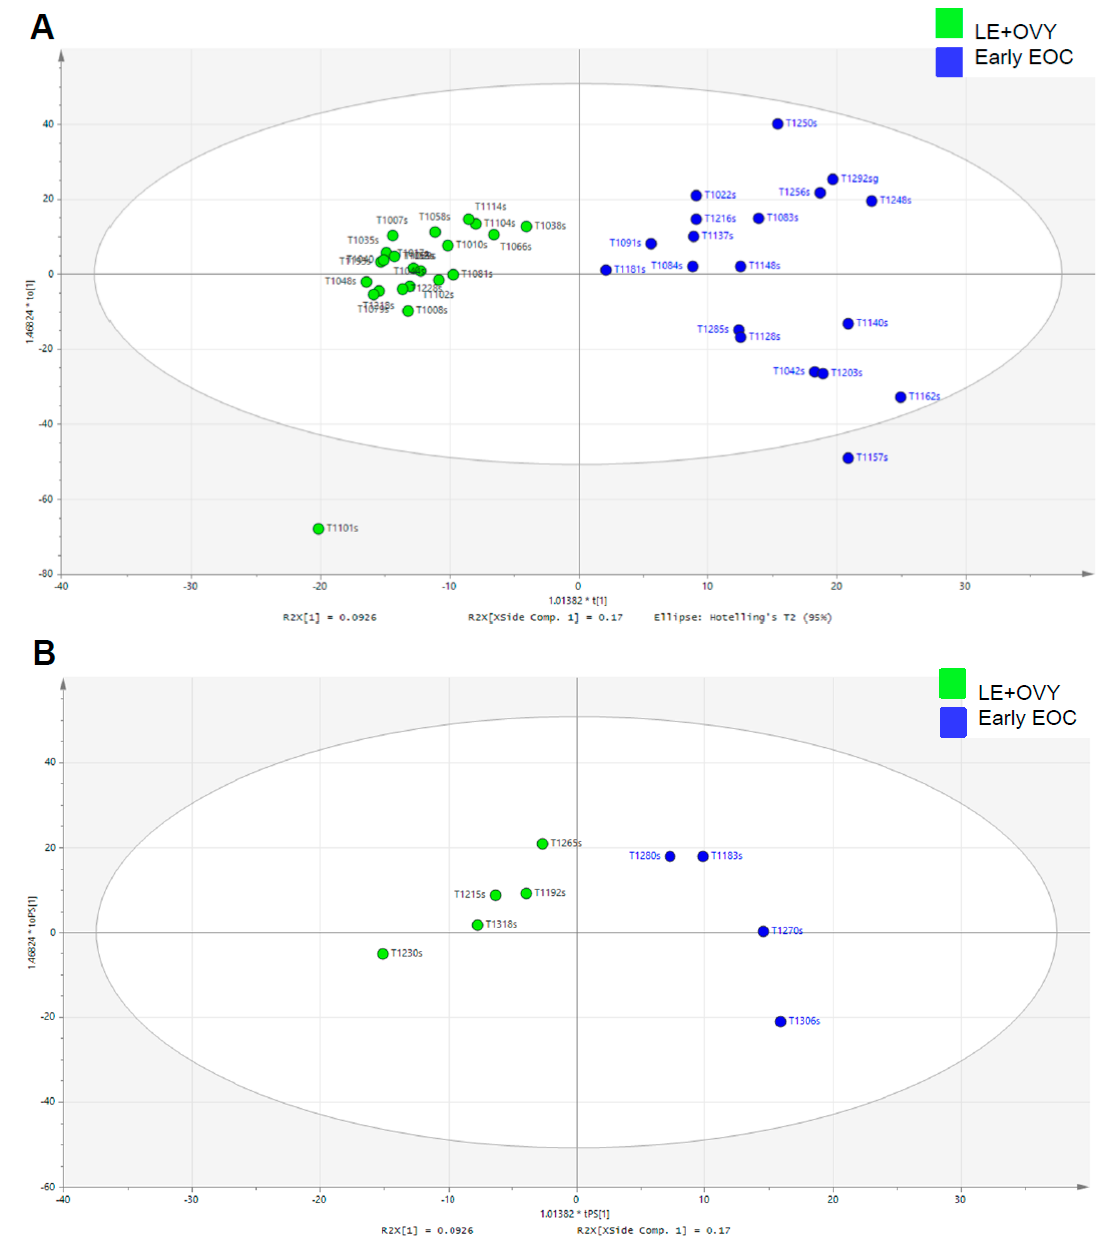
Figure 2. Glycopeptide spectral data in a cancer group and a non-cancer group. ( A ) OPLS-DA scatter plot based on the same samples as in panel B . Green dots are LE and OVY samples and blue dots are EOC patients. The ellipse represents 95%CI. ( B ) Scores plots of the OPLS-DA prediction model for validation set. Green dots are LE and OVY samples and blue dots are EOC patients. The ellipse represents 95% confidence interval. Abbreviations: EOC, epithelial ovarian cancer; LE, leiomyoma; and OVY, ovarian